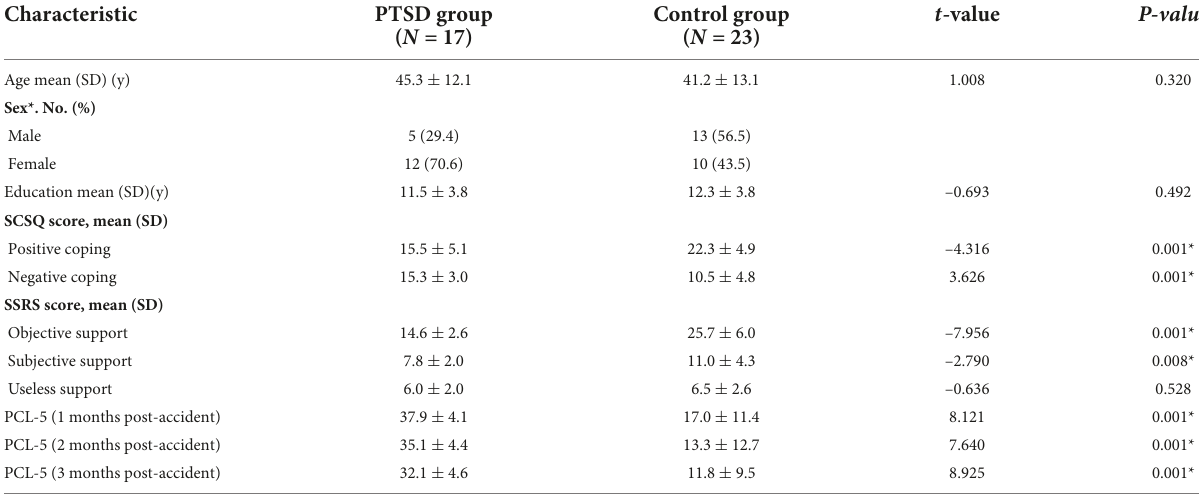
TABLE 1 Demographic data and psychological stress response scores at baseline and PCL-5 scores at 3 months of follow-up in PTSD patients and controls after motor vehicle accident. Characteristic PTSD group